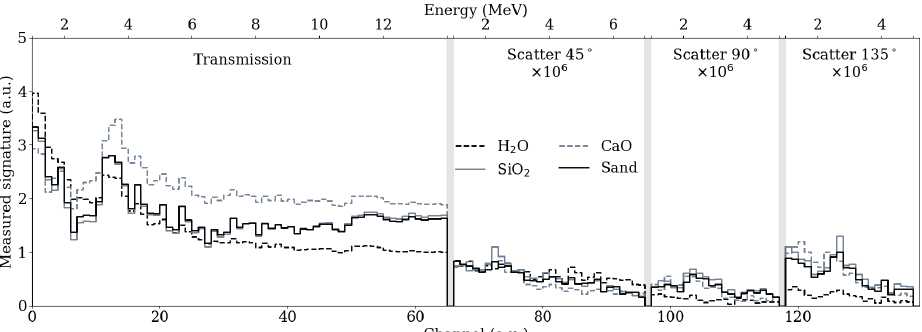
Fig. 4. Transmitted and scattered neutron signatures for the composite materials H 2 O, SiO 2 , CaO and sand as defined in Table 1. Statistical uncertainties have been excluded for clarity, but are below 1 % for the transmission signatures, and below 10 % for the scattered